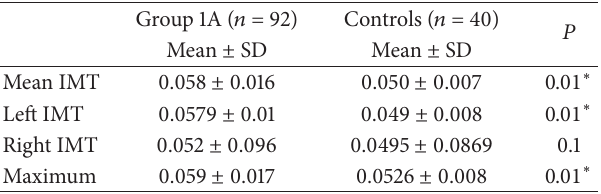
Table 5: Comparison of ultrasonographic duplex findings in group 1A patients and